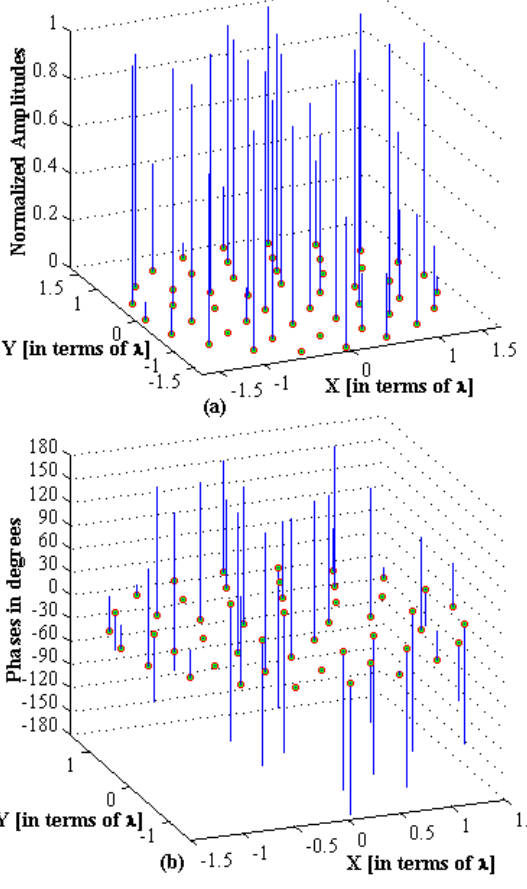
Figure 4: Optimum excitations (a) Amplitudes and (b)